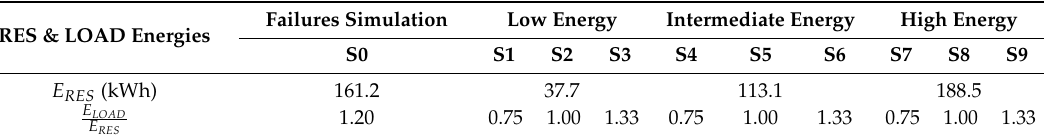
Table 2. Characteristics of the ten simulation scenarios.